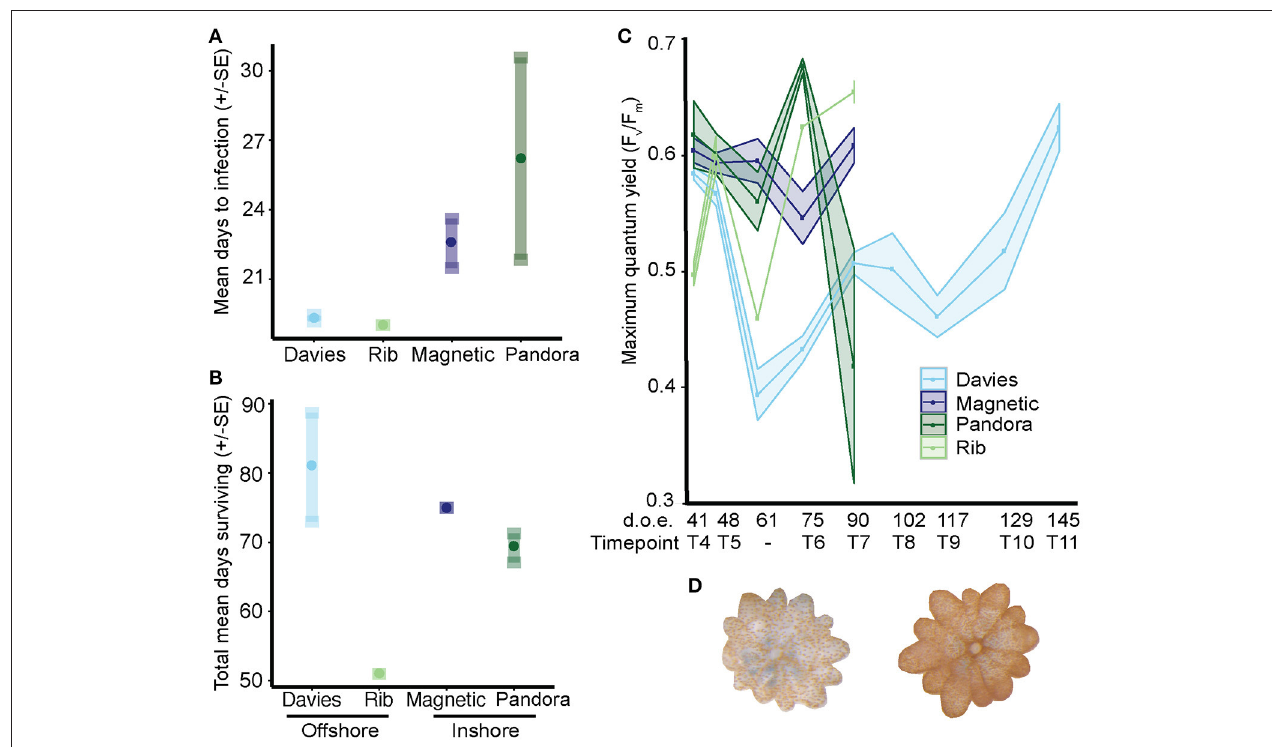
FIGURE 8 | Time to infection and survival of Acropora tenuis juveniles exposed to sediments from central GBR sites. Inshore reefs are in darker shades and offshore sites in lighter shades (see x-axis). (A) Mean time to infection ± SE per sediment treatment. Circles represent means; minimum and maximum values are located at the end of each standard error whisker. (B) Juvenile survival in days (mean ± SE) per sediment treatment. (C) Maximum quantum yield (F v /F m ) of juveniles from 52–166 days post-fertilization. Due to low survivorship and cumulative sampling of Rib recruits, only one individual was measured at days 59 and 72, and two individuals at day 102, which represents the number of days of exposure to treatments. (D) Two juveniles from the Davies sediment treatment at day 117, highlighting the level of variation in symbiont proliferation within juveniles exposed to sediments from different